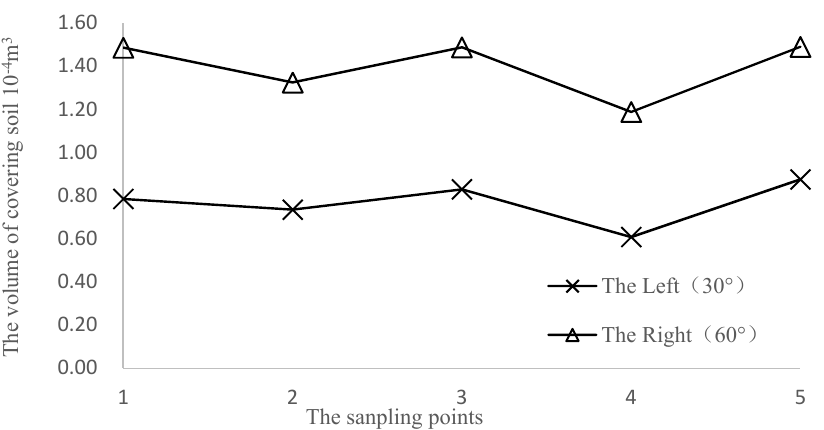
Figure 10. The volume of covered soil at different sampling point (Both the angles of left and right disc are 30 ◦ and 60 ◦ , respectively).